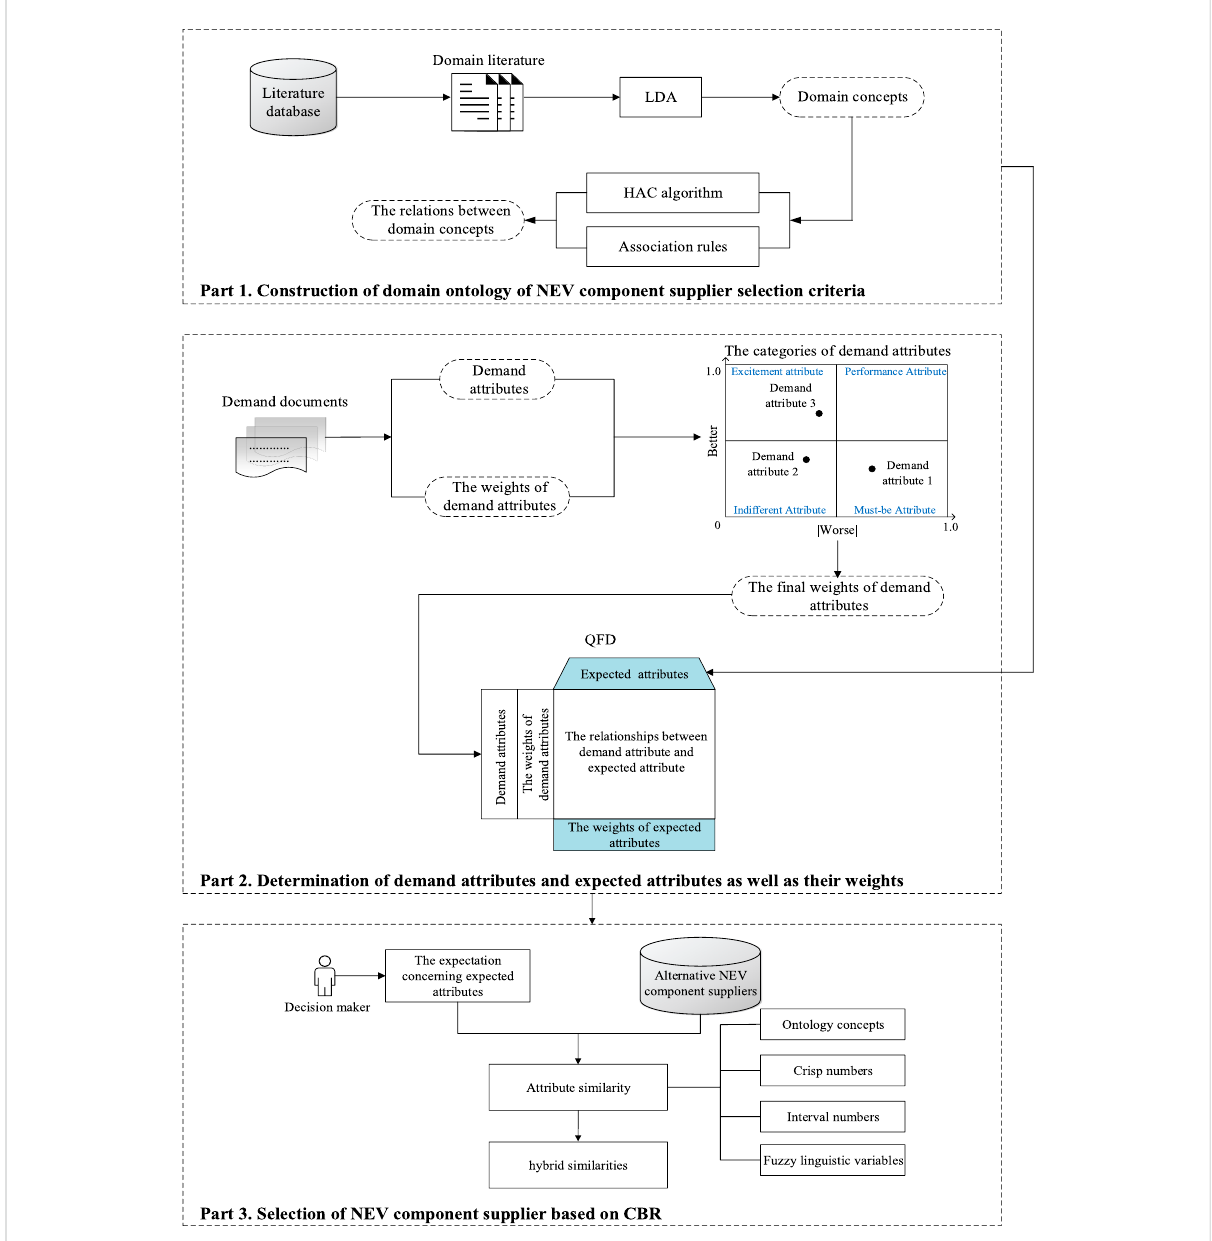
FIGURE 2 Resolution process for the problem of demand-driven NEV supplier